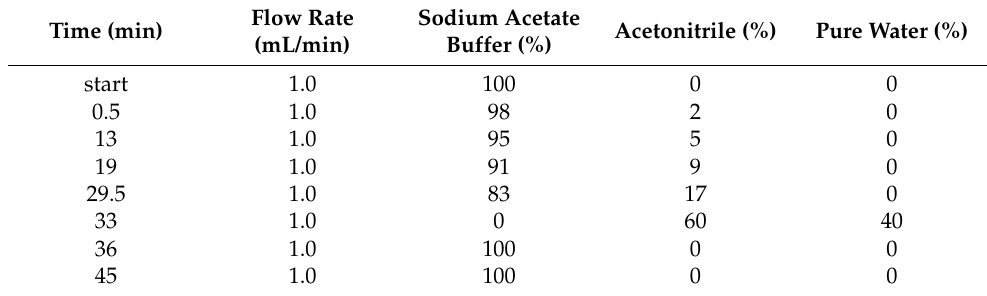
Table 1. The elution gradient of mobile